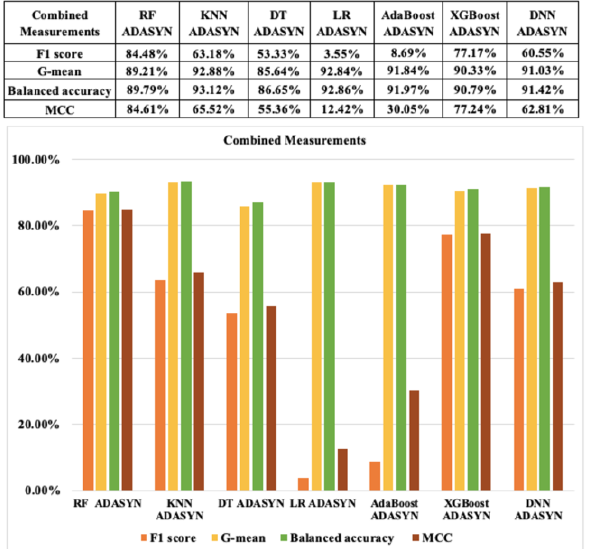
Figure 21. Combined classification performance measurements with ADASYN SMOTE based on resampling approach 2.